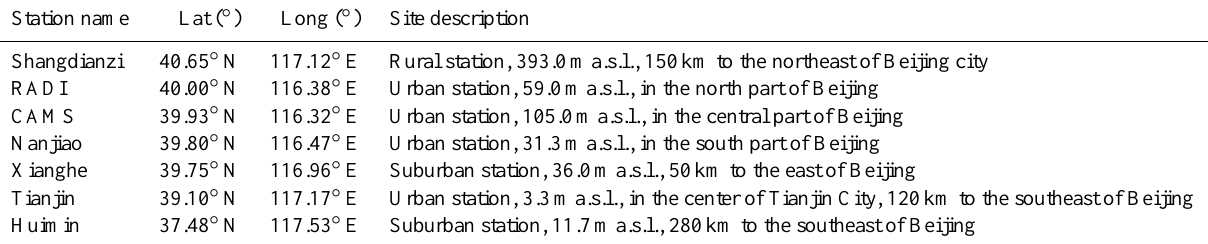
Table 1. Site location and